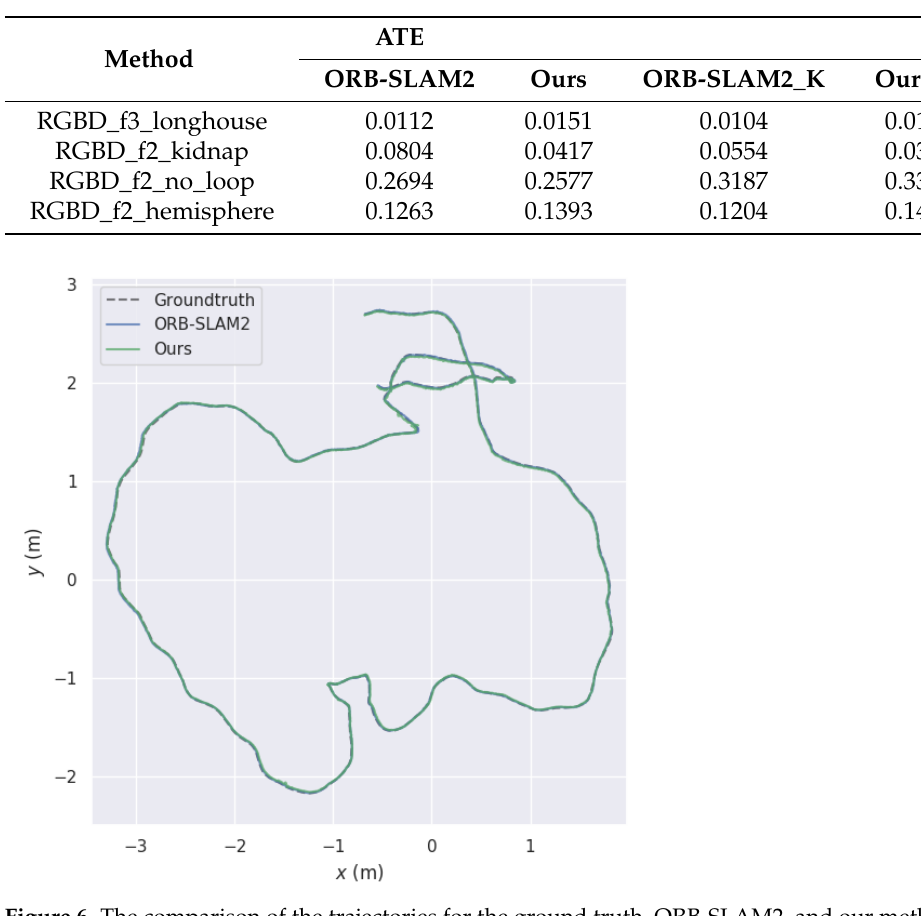
Table 2. The RMSE of the ATE (m) for all frames and key frames of two frameworks.